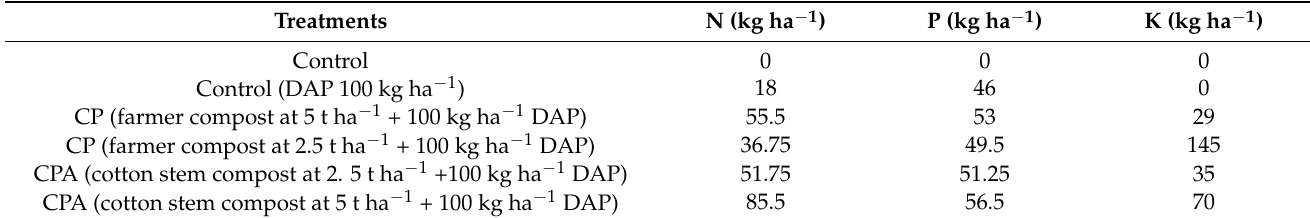
Table 2. Nutrient application per